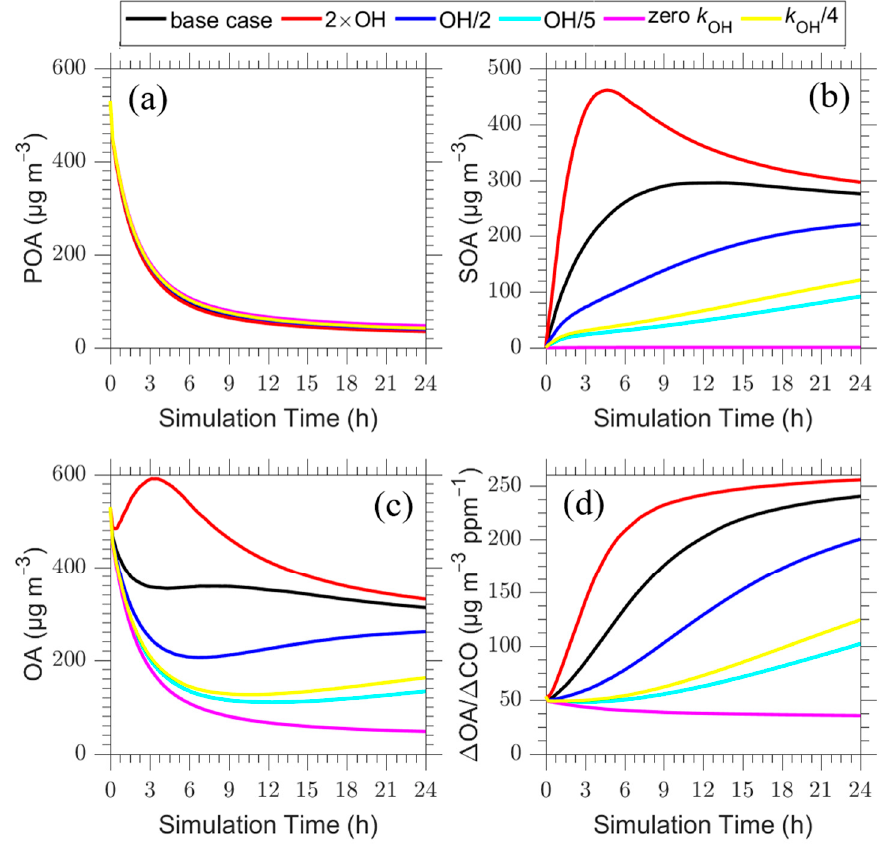
Figure 4. Time series of: ( a ) POA; ( b ) SOA; ( c ) total OA; and ( d ) Δ OA/ Δ CO for the plume centerline for the base case ( black line ) and scenarios of increased OH by a factor of 2 ( red line ), decreased OH by a factor of 2 ( blue line ) and a factor of 5 ( cyan line ), aging rate constant equal to zero ( magenta line ) or decreased by a factor of four ( yellow line ).